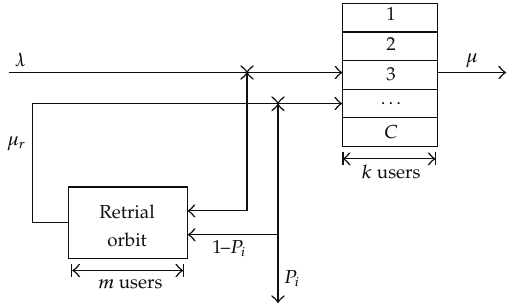
Figure 1: Retrial model under